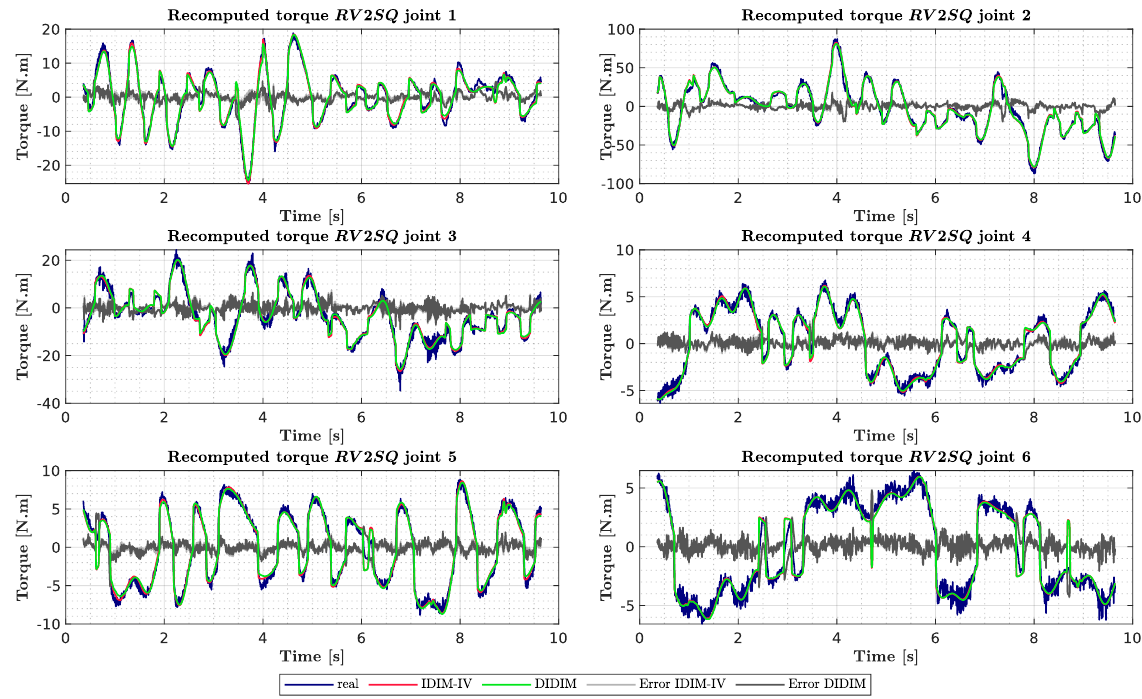
Figure 10. Reconstructed IDIM-IV and DIDIM torque signals during the validation experiment on the real RV2SQ